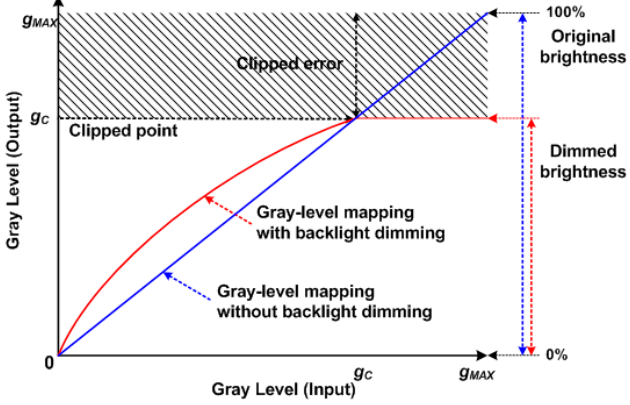
Figure 1. Gray-level mapping between input and output signals in the backlight dimming.